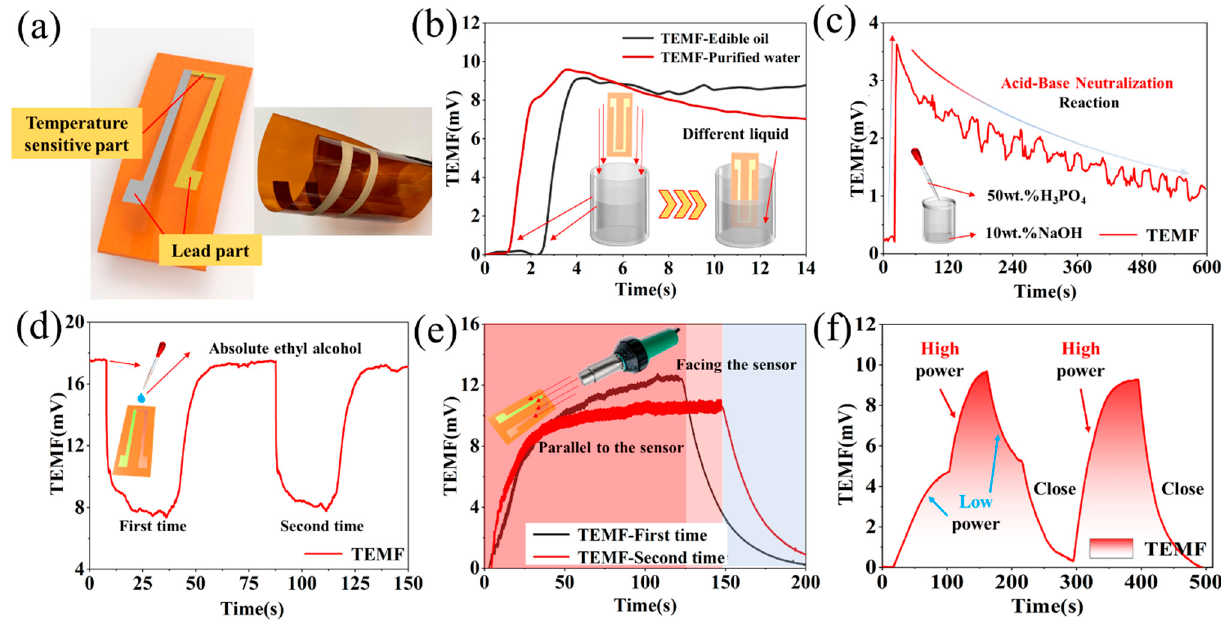
Figure 5. Conduct a full range of practical application tests on the sensor. Perform multiple tests on the sensor in the actual application environment and different temperature stimuli: ( a ) Schematic diagram and the sample of the flexible temperature sensor; ( b ) Temperature test of hot soybean oil and deionized water solution; ( c ) Monitor the real-time changes in the temperature of the acid-base neutralization reaction; ( d ) Temperature measurement of absolute ethyl alcohol volatilization; ( e ) Airflow temperature detection of hot air welding machine; ( f ) Temperature detection of electric heaters based on heat radiation.